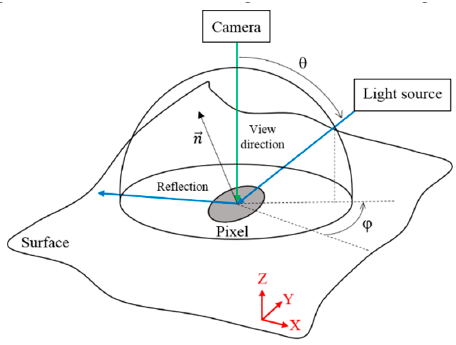
Figure 4. Reflectance transformation imaging.